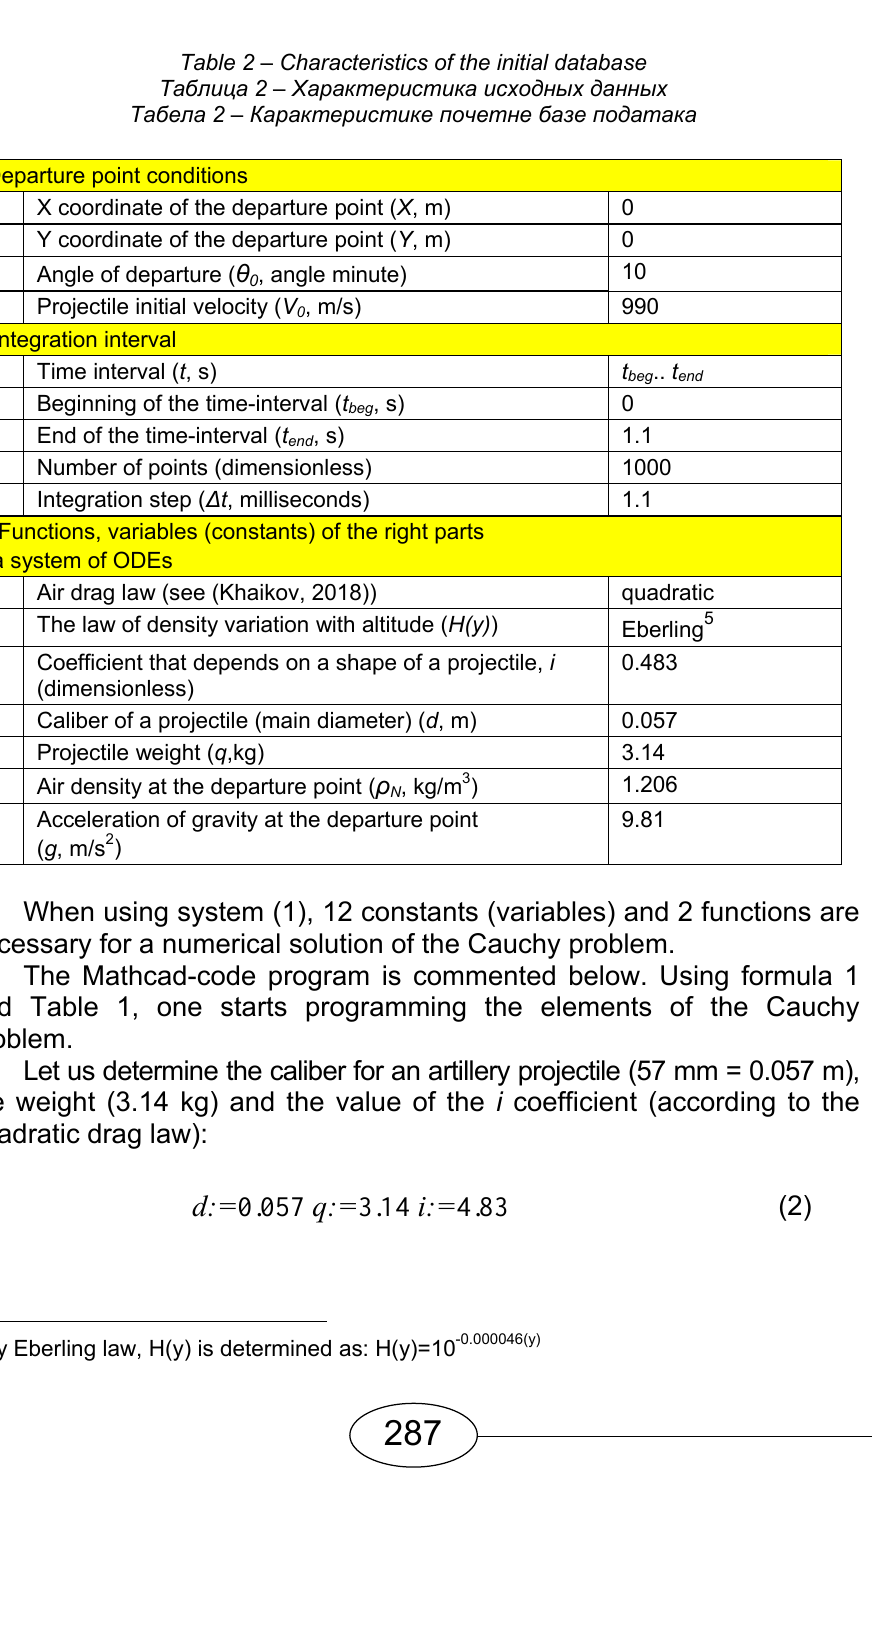
303 Table 2 – Characteristics of the initial database -